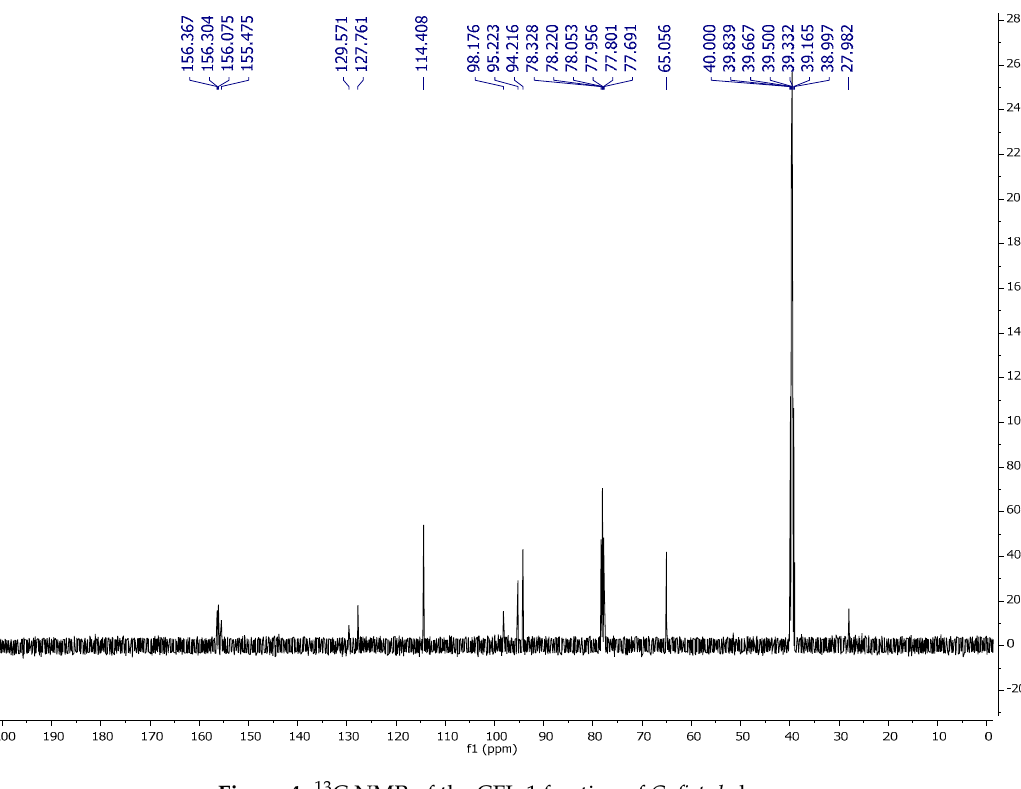
Figure 4. 13 C NMR of the CFL-1 fraction of C. fistula leaves.